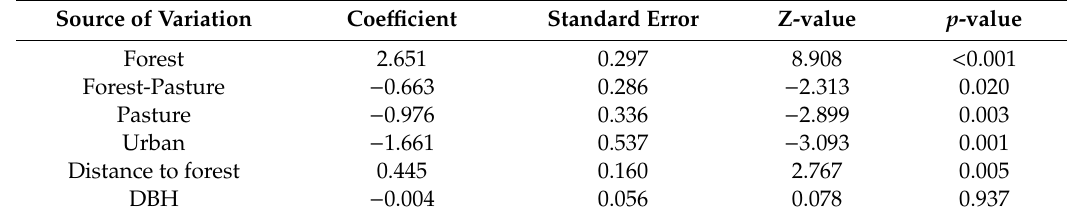
Table 2. Summary of the GLMM applied on species richness in four riparian land uses of Andean streams in southern Ecuador. Significant di ff erences at p -value < 0.05. DBH: diameter at breast height.